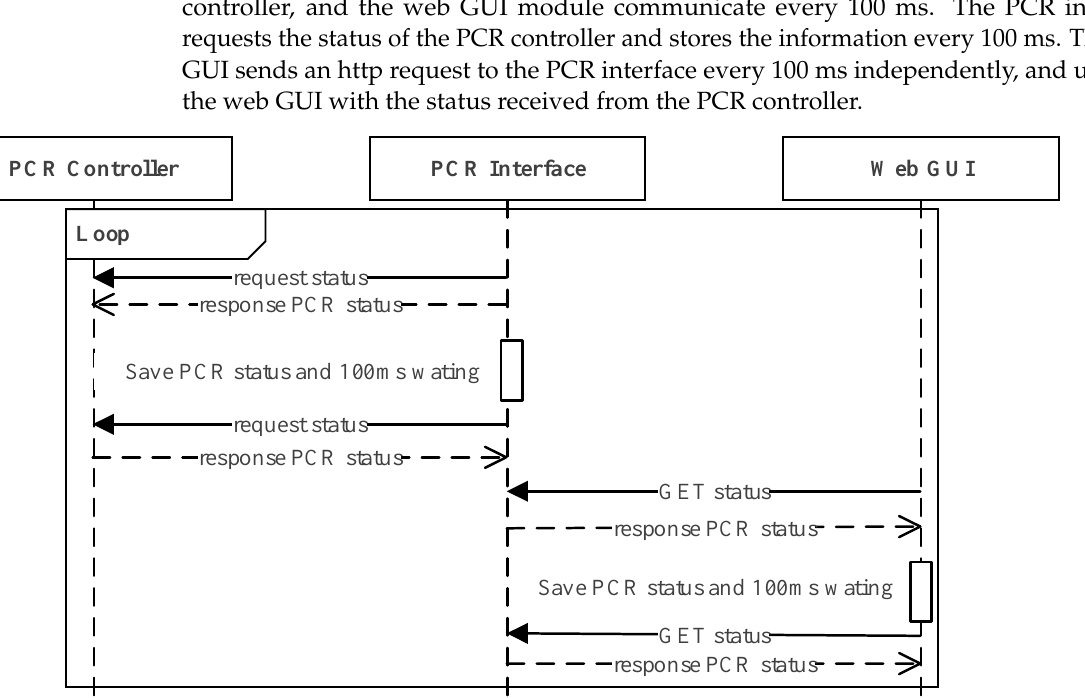
Figure 6. Interaction scenario in which PCR interface, PCR controller, and web GUI module communicates every 100 ms.